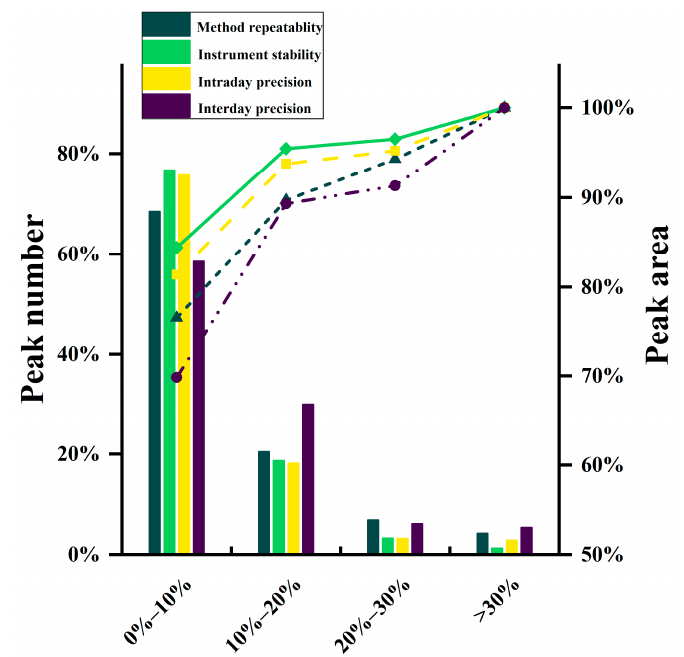
Figure 5. The base peak chromatogram of the flue-cured NTL leaves from different maturity grades. ( A ) The base peak chromatograms (BPC) plot of unripe leaves at m/z range of 50–1000; ( B ) the BPC plot of ripe leaves at m/z range of 50– 1000; ( C ) the BPC plot of overripe leaves at m/z range of 50–1000.